Question: Write a single sentence explaining what this figure depicts.
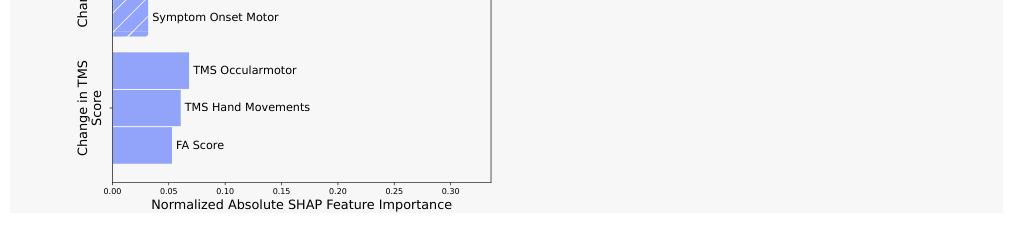
Answer: SHAP values for the Neurodegeneration therapeutic Area. For each patient, SHAP values for each baseline feature are first taken as absolute values, then normalized so that their sum equals one. This process is repeated for each of three important outcomes for each indication indicated in the y-axis label. Finally, these normalized SHAP values are averaged across all patients to derive the average contribution of each feature per outcome.